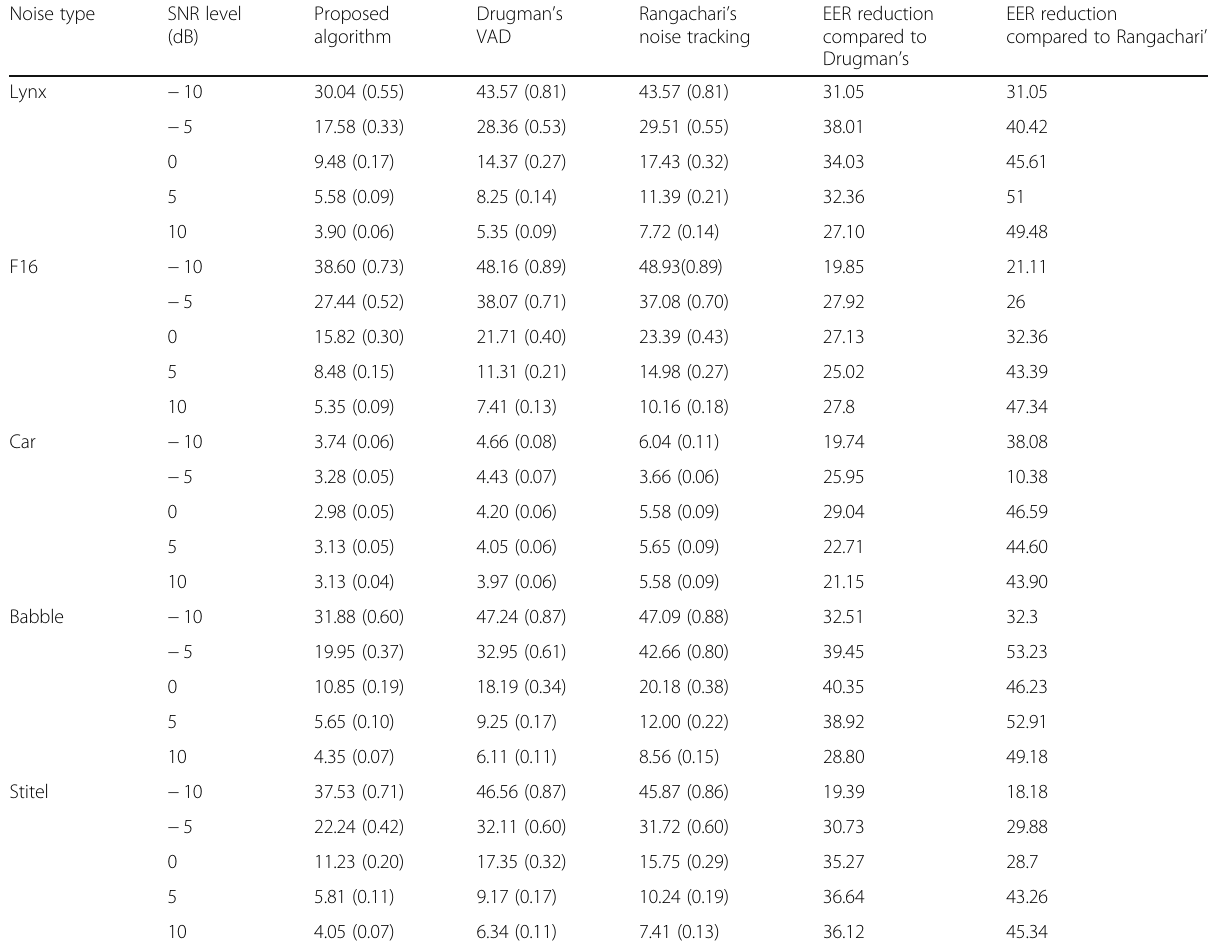
Table 5 Male speaker verification results of i-vector method in terms of percent EER (minDCF) for the proposed algorithm, Drugman ’ s VAD method [27], and Rangachari ’ s noise tracking method [21]. The last columns show the relative percent EER reduction rates compared to Drugman ’ s VAD and Rangachari ’ s method, respectively Noise